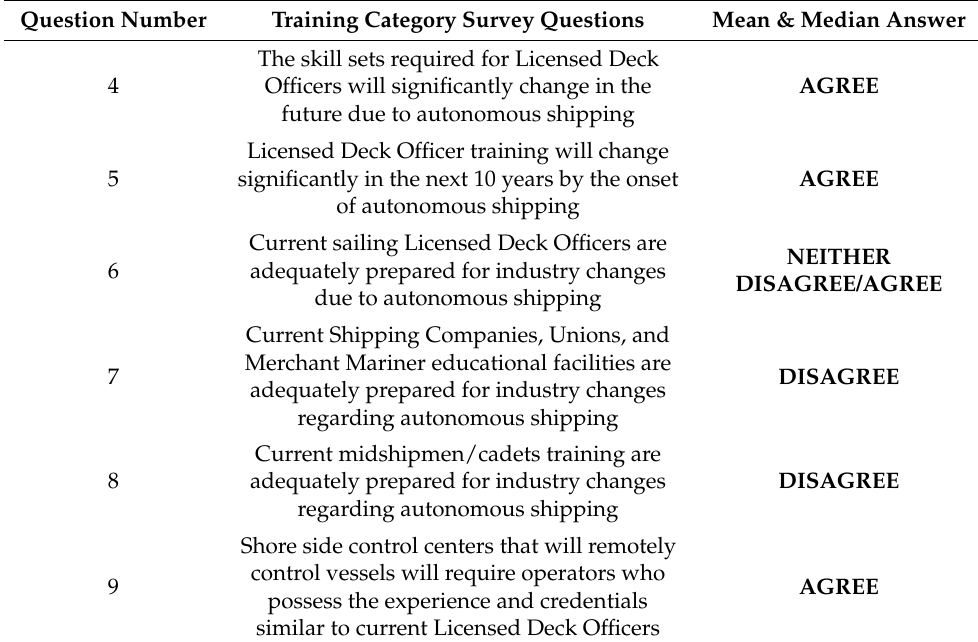
Table 1. Training Category survey questions and response